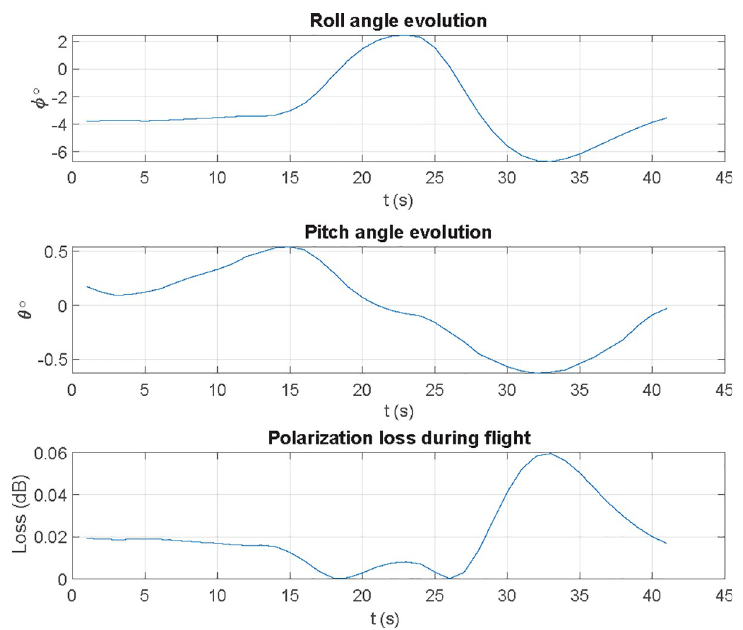
Fig 15. Decoupling losses in a real flight for pitch and roll motions.